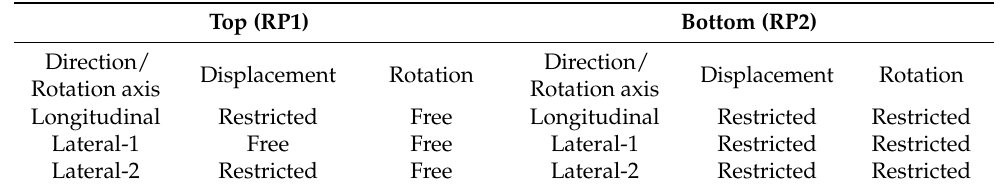
Table 4. Boundary conditions.